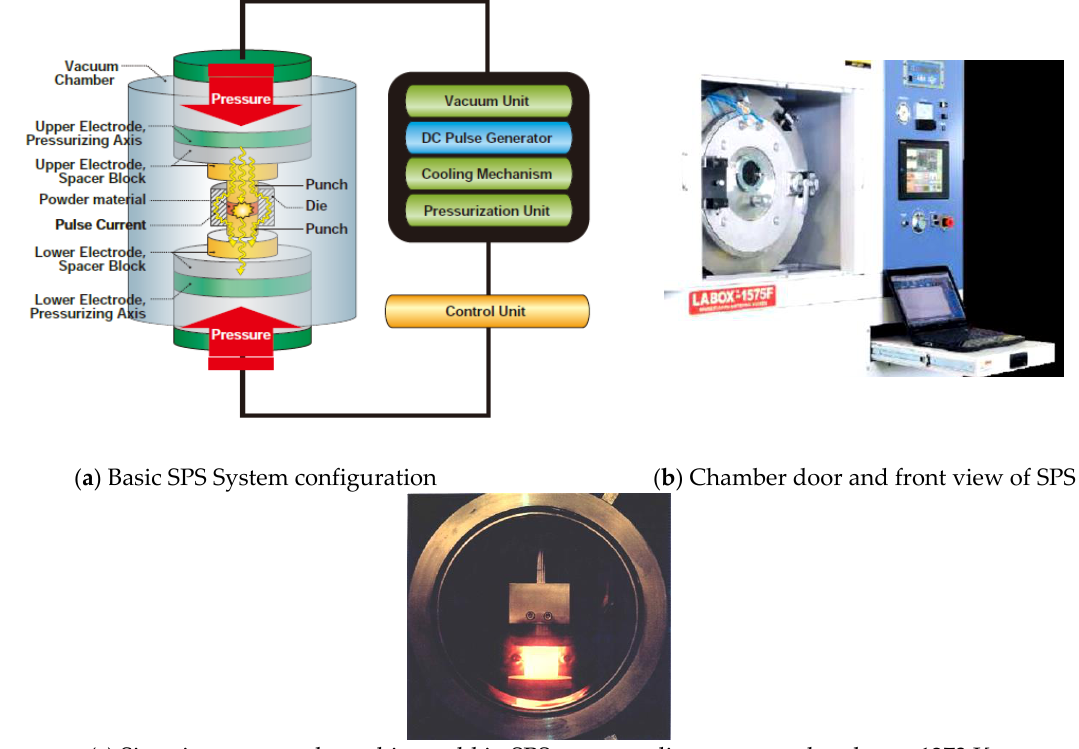
Figure 7. Basic SPS System configuration: ( a ) System configuration; ( b ) Chamber door and front view of SPS apparatus, ( c ) Sintering stage and graphite mold in SPS water cooling vacuum chamber at 1273 K.